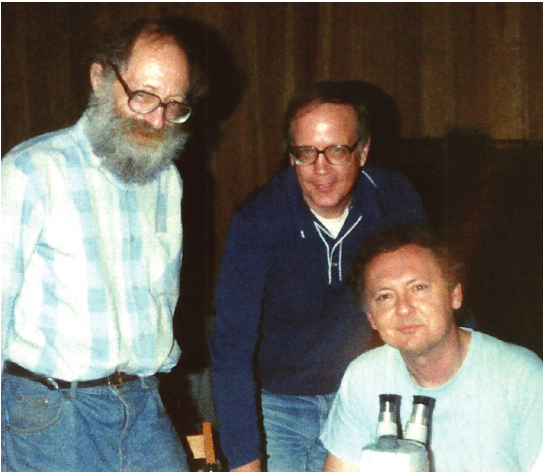
Figure 3. Left to right: Izya Kerzhner, Al Wheeler, and Tom Henry working in the West Virginia cabin, 1994.